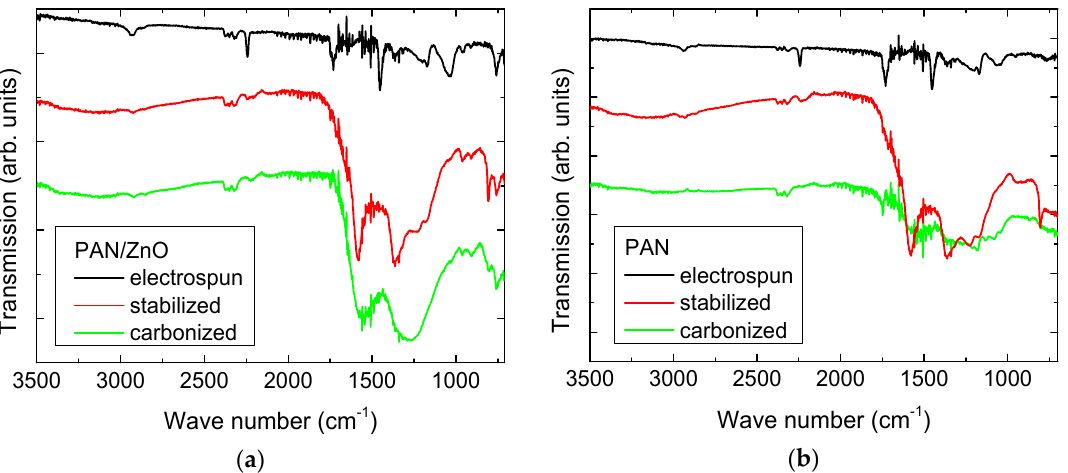
Figure 6. FTIR graphs of electrospun, stabilized and carbonized nanofiber mats from ( a ) PAN/ZnO; ( b ) PAN.